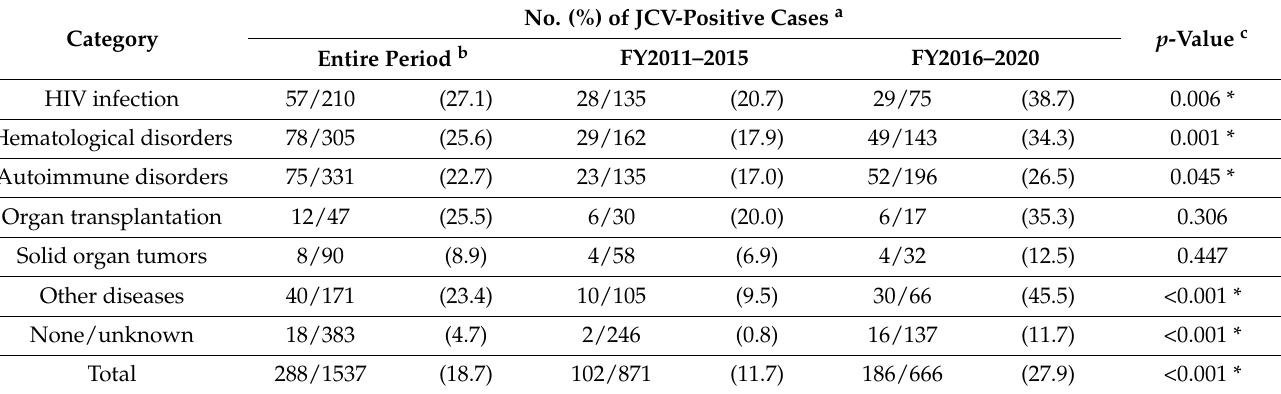
Table 1. Underlying disease categories and detection rates in patients with JCV-positive